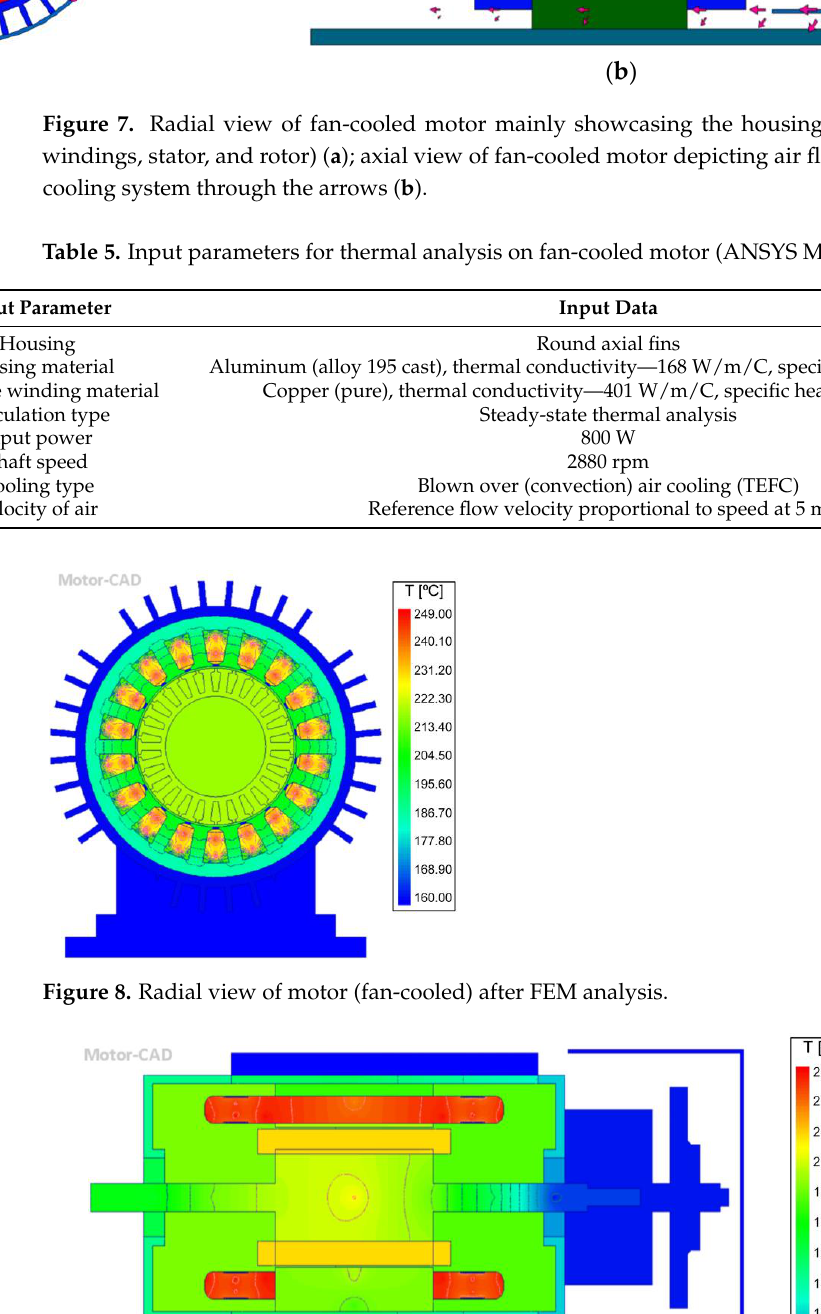
Figure 8. Radial view of motor (fan-cooled) after FEM analysis.